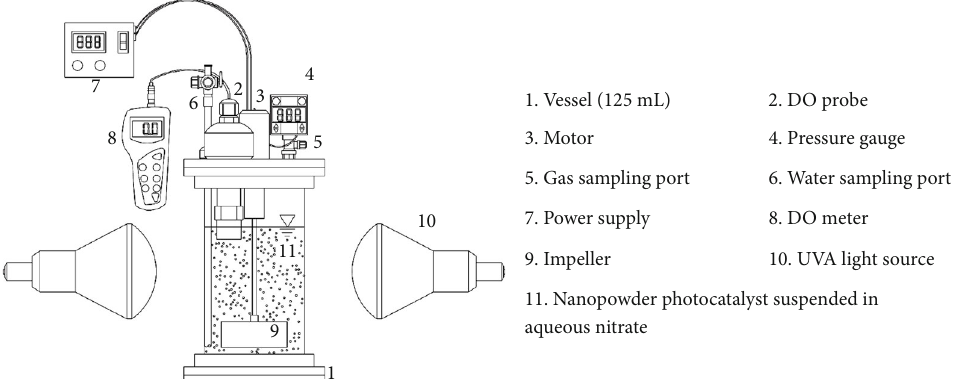
Figure 1: Schematic of photoreactor for nitrate